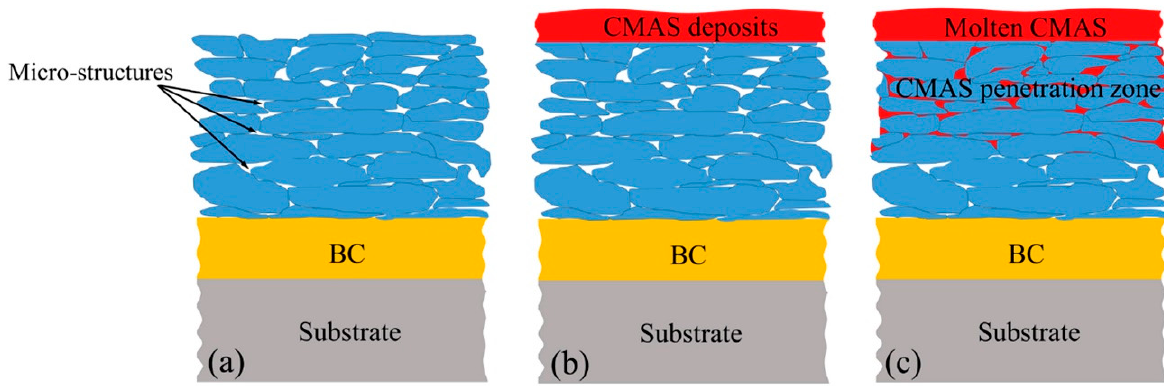
Figure 1. Schematic diagram of the penetration process of CaO-MgO-Al 2 O 3 -SiO 2 (CMAS) into atmospheric plasma spraying (APS) TBCs [4]: ( a ) Structure of TBCs, ( b ) CMAS depositing on the TBCs surface, ( c ) Liquefied CMAS penetrating the top ceramic